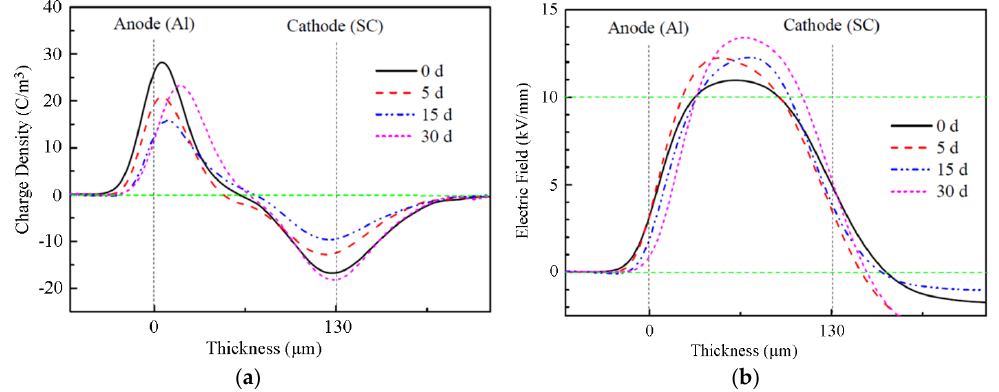
Figure 12. Space charge ( a ) and corrected electric field distribution profiles ( b ) of oil ‐ paper aged for different days, measured at the end of 30 min polarization under 10 kV/mm electric field [23].